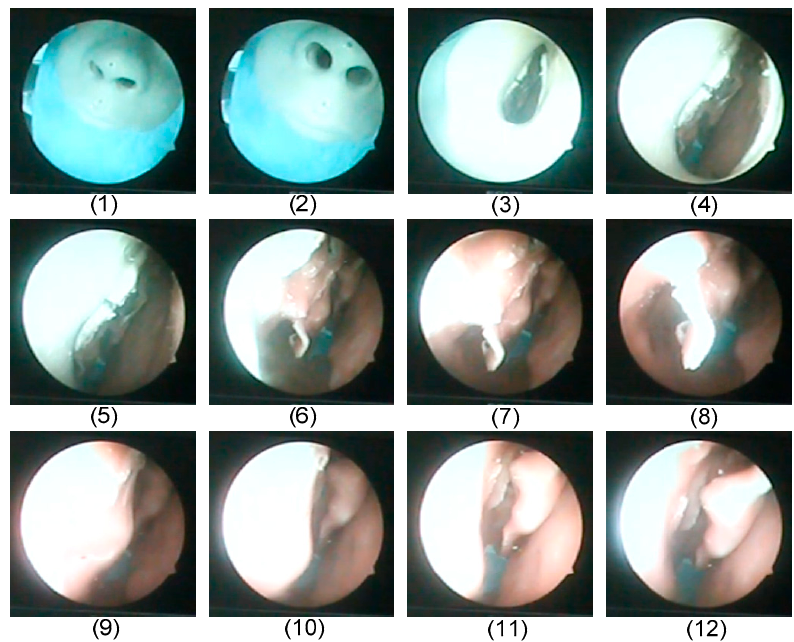
Figure 16. The endoscope tip trajectory and the preoperative planned trajectory.